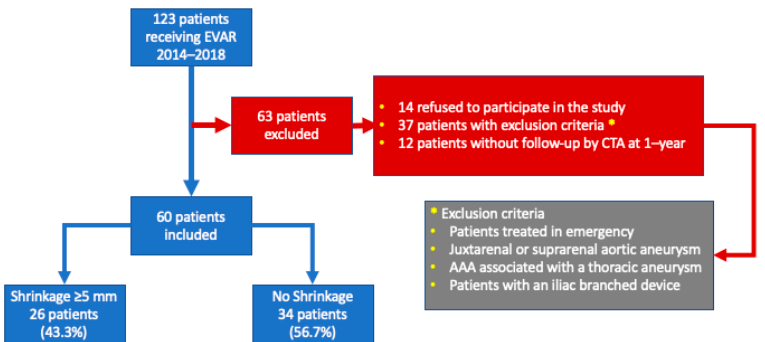
Figure 1. Flowchart of the